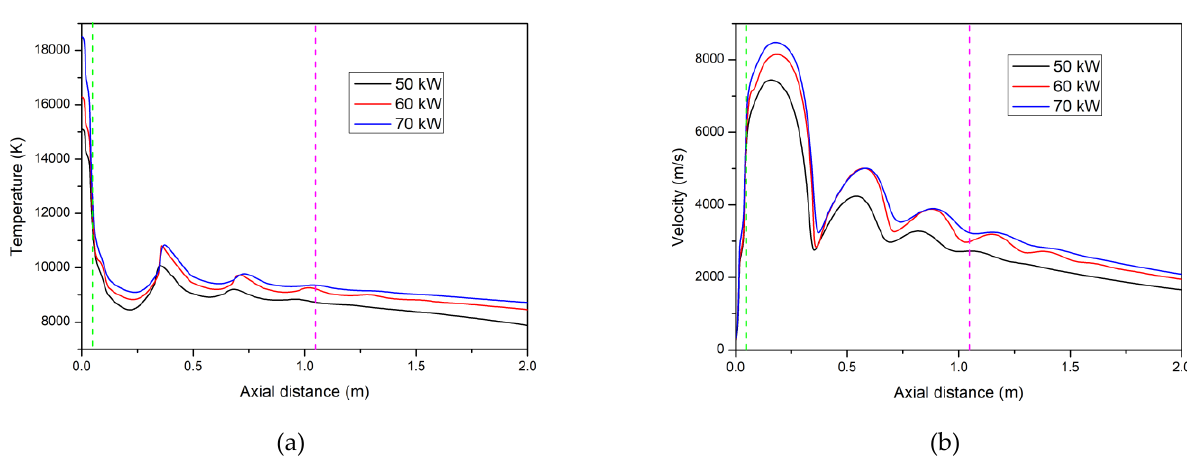
Figure 6. Variation of the temperature ( a ) and velocity ( b ) of the plasma jet along the jet axis for different net electric powers. 60 SLPM of argon, 30 SLPM of helium, chamber pressure: 100 Pa. The green vertical dotted line indicates the location of the plasma torch nozzle exit. The purple vertical dotted line indicates the location of the substrate during actual coating deposition.